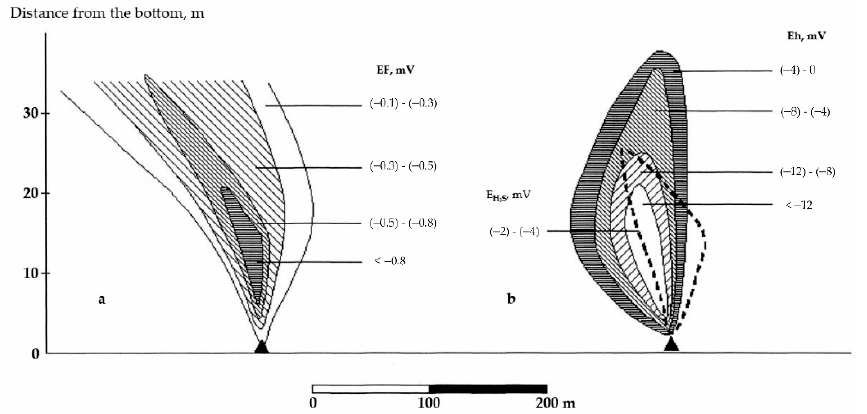
Figure 6. The structure of the geophysical (( a ) EF) and geochemical (( b ) Eh and E H2S ) anomalies above the active hydrothermal structure Irina-2 (Logachev field) [38].